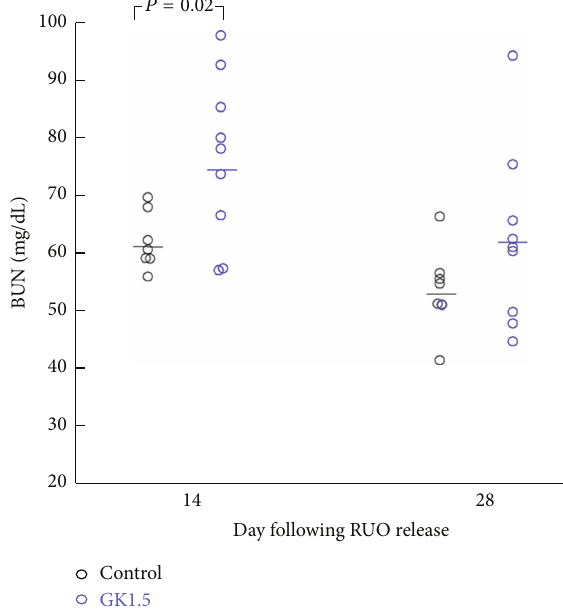
Figure2:BUNmeasurementsinCD4-depleted(GK1.5)andcontrol mice on days 14 and 28 following release of UUO. On day 7, all animals had removal of the contralateral (unobstructed)